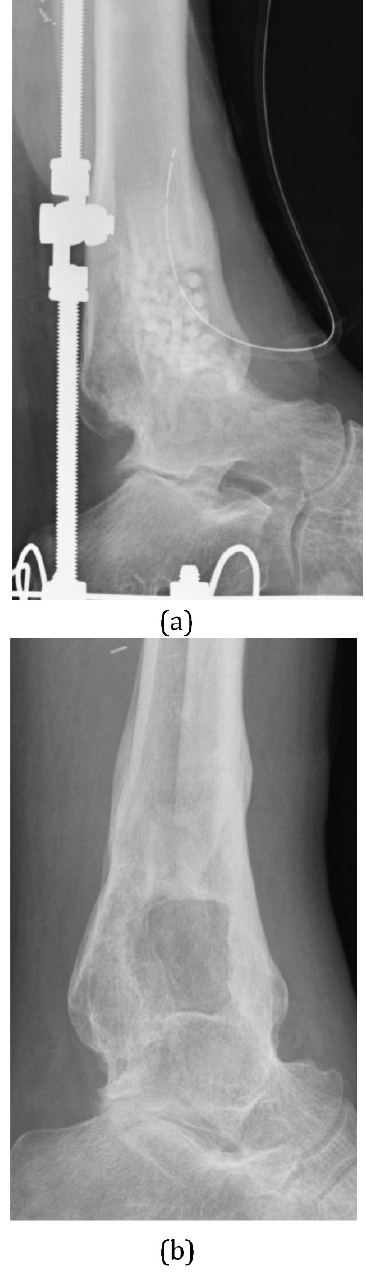
Figure 3. (A) This infected ankle fusion was treated by radical excision, Ilizarov stabilisation and filling of the cortico-medullary defect with Calcium Sulphate pellets containing Tobramycin. (B) At one year after surgery, the patient is infection-free and the biocomposite has dissolved. There is almost no new bone formation within the resection